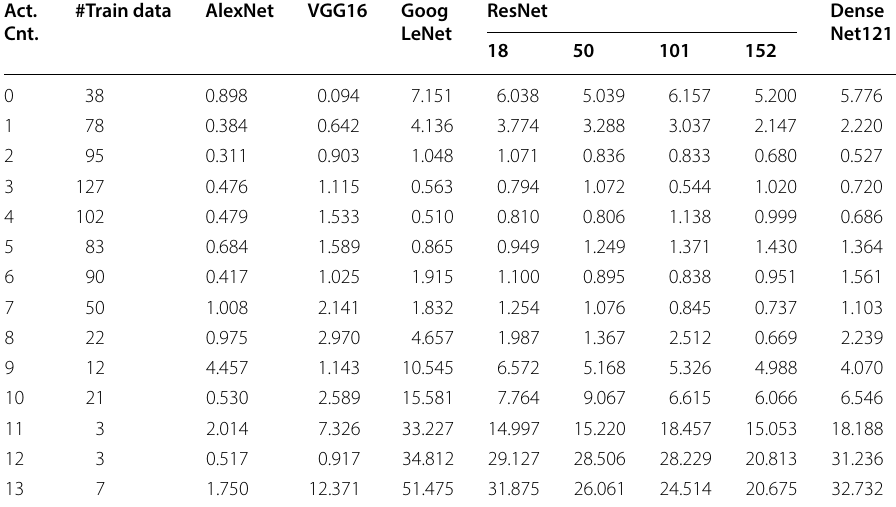
Table 4 Test MSE of all models for each actual count Act.